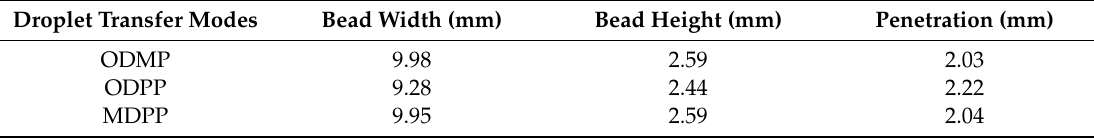
Table 4. The parameters of the cross-section appearance of beads.